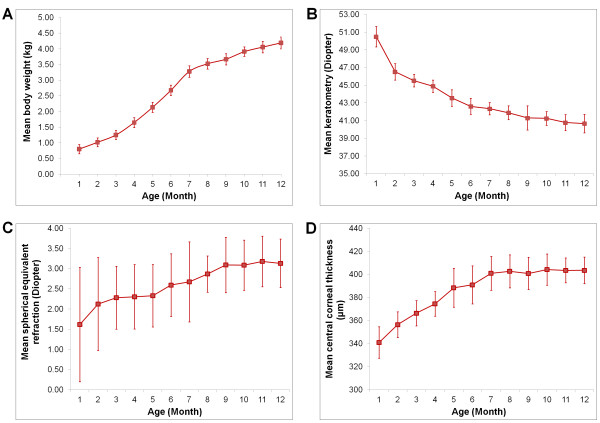
Age-related changes in body weight (A), corneal curvature (B), refractive state (C) and central corneal thickness (D). Error bars represent standard deviation of the mean value.